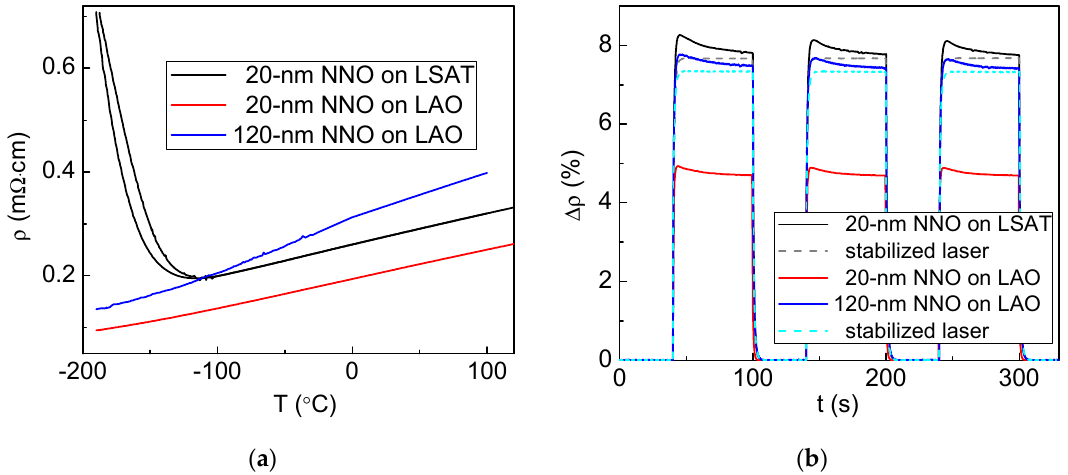
Figure A2. ( a ) Resistivity temperature dependence for other tested NNO films: two 20-nm thick films deposited on LSAT and LAO and a 120-nm thick film on LAO. ( b ) Percentage change of their room-temperature resistivity at periodical 60-s illumination by the blue laser at optical power 0.8 W.